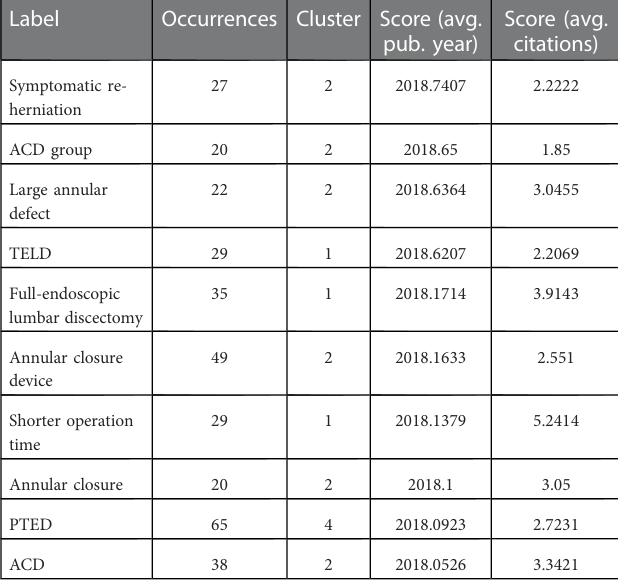
TABLE 2 The 10 most recent hotspots according to the average publication year.